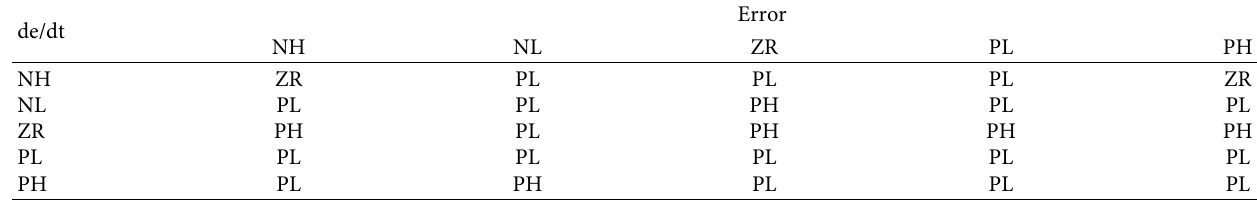
Table 2: If-then fuzzy logic rule base for ∆ k